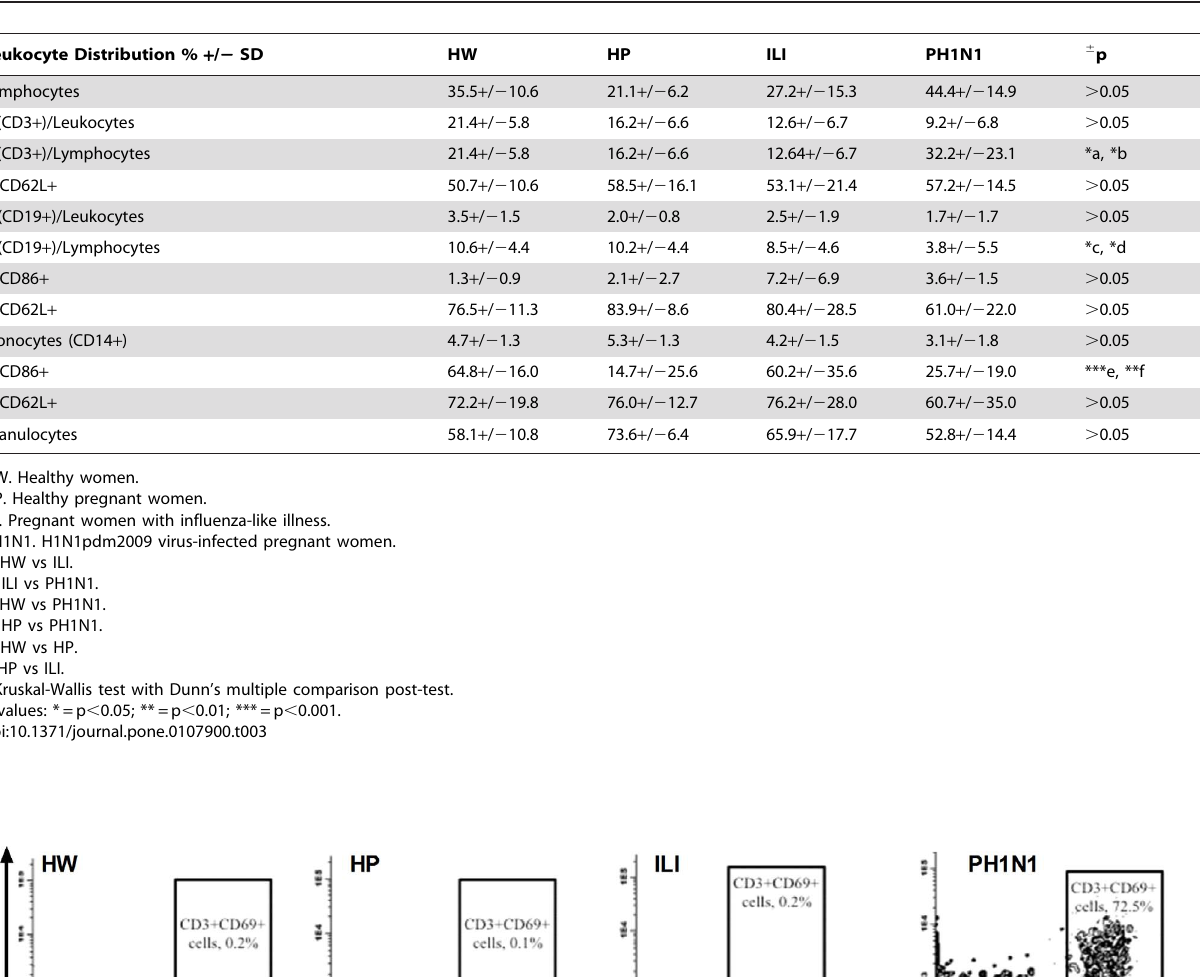
Table 3. Distribution of leukocytes in the blood.